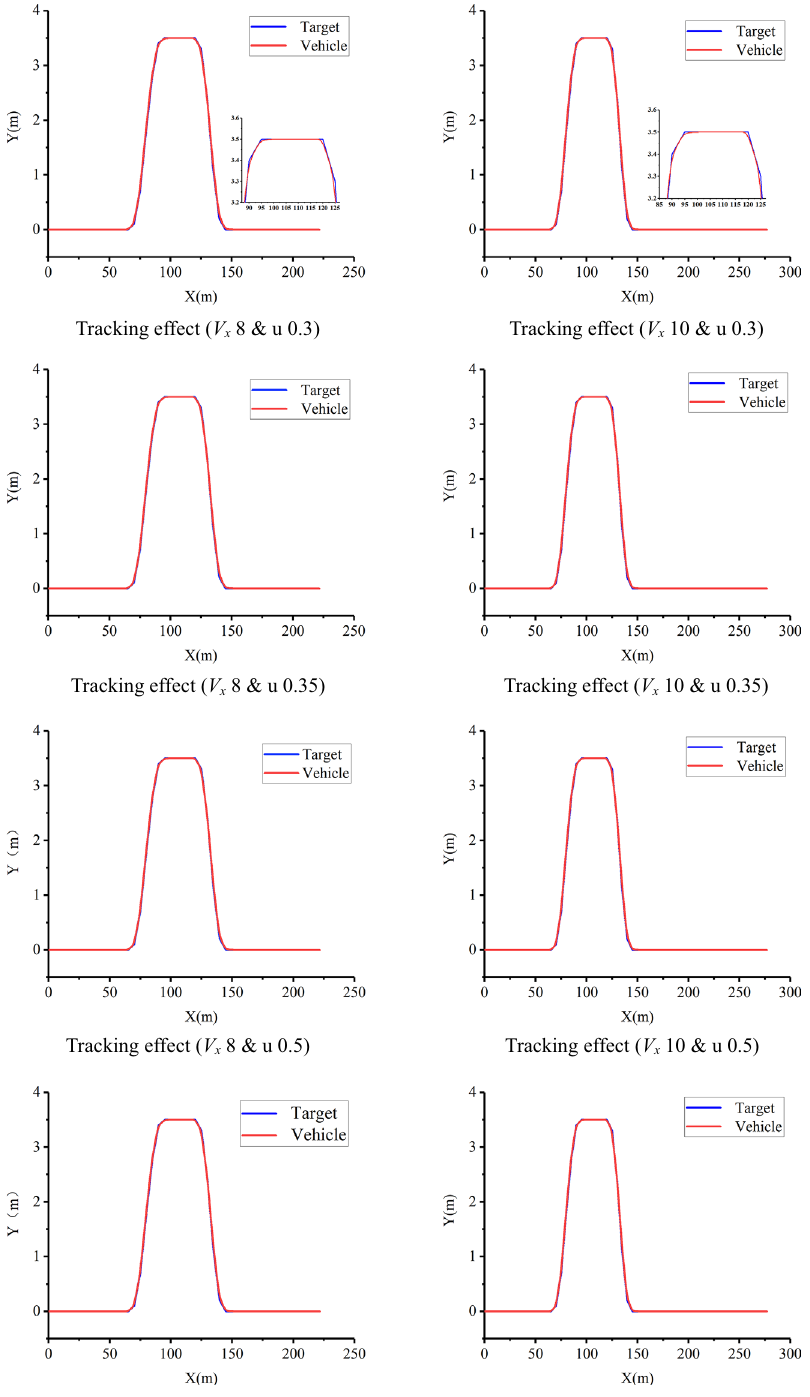
Figure 30. Comparison of the tracking